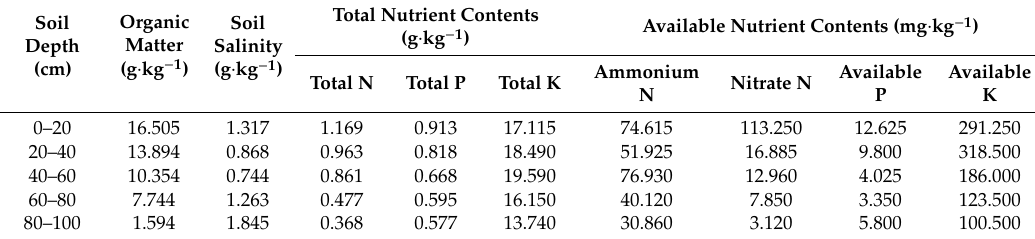
Table 3. Soil chemical characteristics in the experimental area.